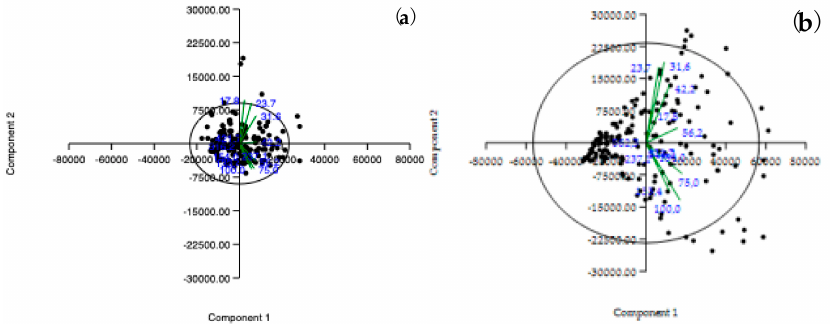
Figure 7. Principal Component Analysis (PCA) of a typical week in October ( a ) and December ( b ). Component 1: nucleation mode; Component 2: accumulation mode.